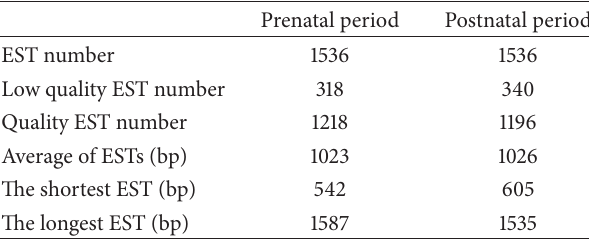
Table 1: The results of analyzing ESTs with Phred software and Geneious